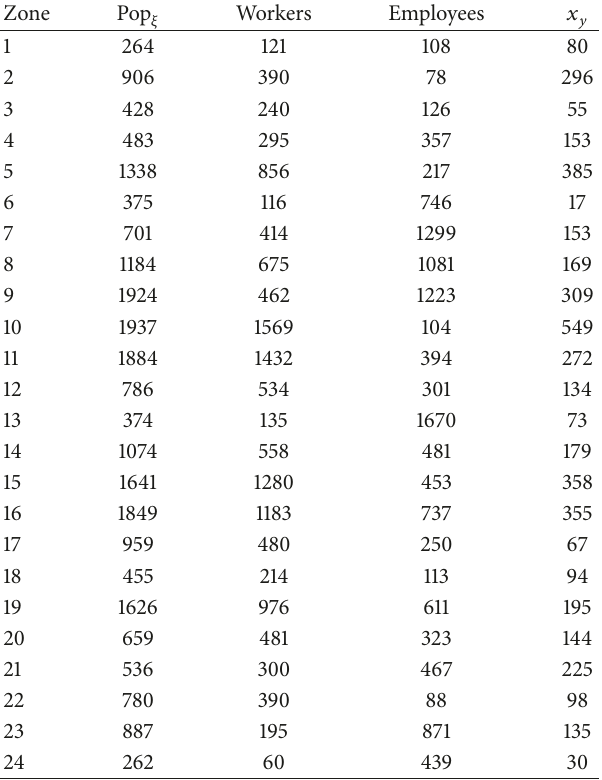
Table 1: Demography of each traffic zone.